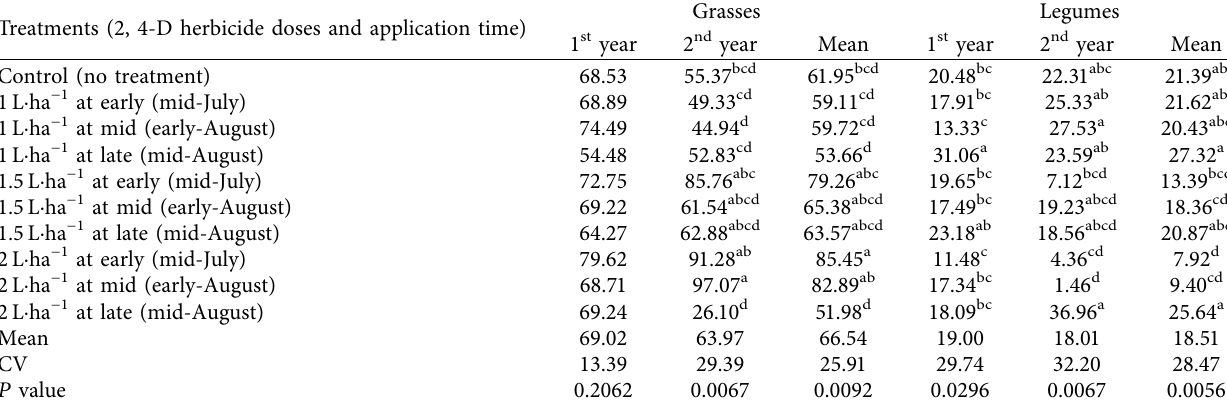
Table 6: Botanical composition (%)/density percentage per · m 2 /of legumes and grasses in natural pasture under different doses and time of 2, 4-D herbicide